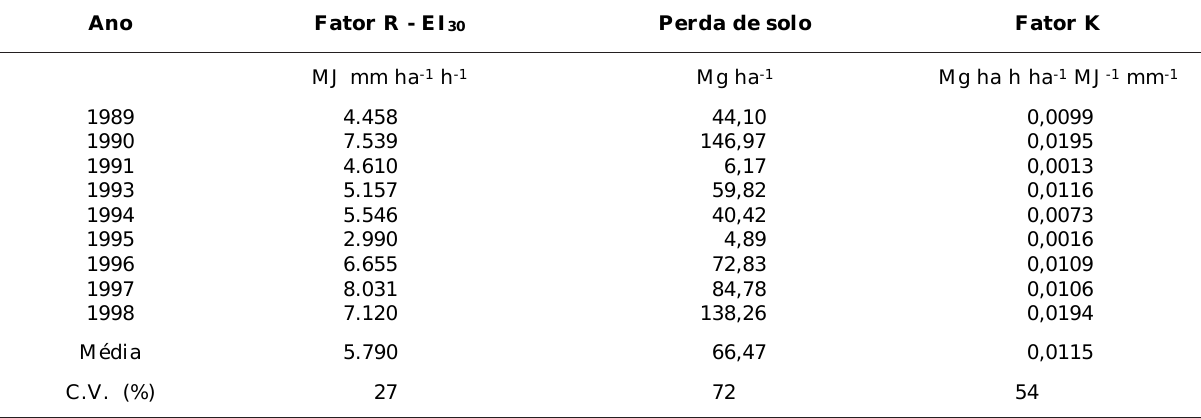
Quadro 1. Valores médios anuais do fator erosividade – EI (fator R) das chuvas, perda de solo (média 30 de duas repetições) e fator erodibilidade (fator K) determinados pelo quociente entre a média das perdas de solo e a média das erosividades das chuvas, do Cambissolo Húmico alumínico léptico em Lages (SC), no período de 1989 a 1998